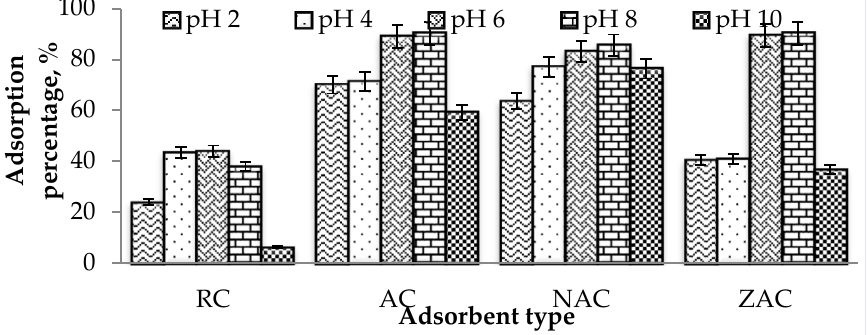
Figure 6. Plot of the adsorption percentage of ofloxacin onto all types of cassava stem adsorbents against different initial pH of the adsorbate (conditions: contact time = 120 min; initial ofloxacin concentration = 100 ppm; temperature = 35 ◦ C; dosage = 1.5